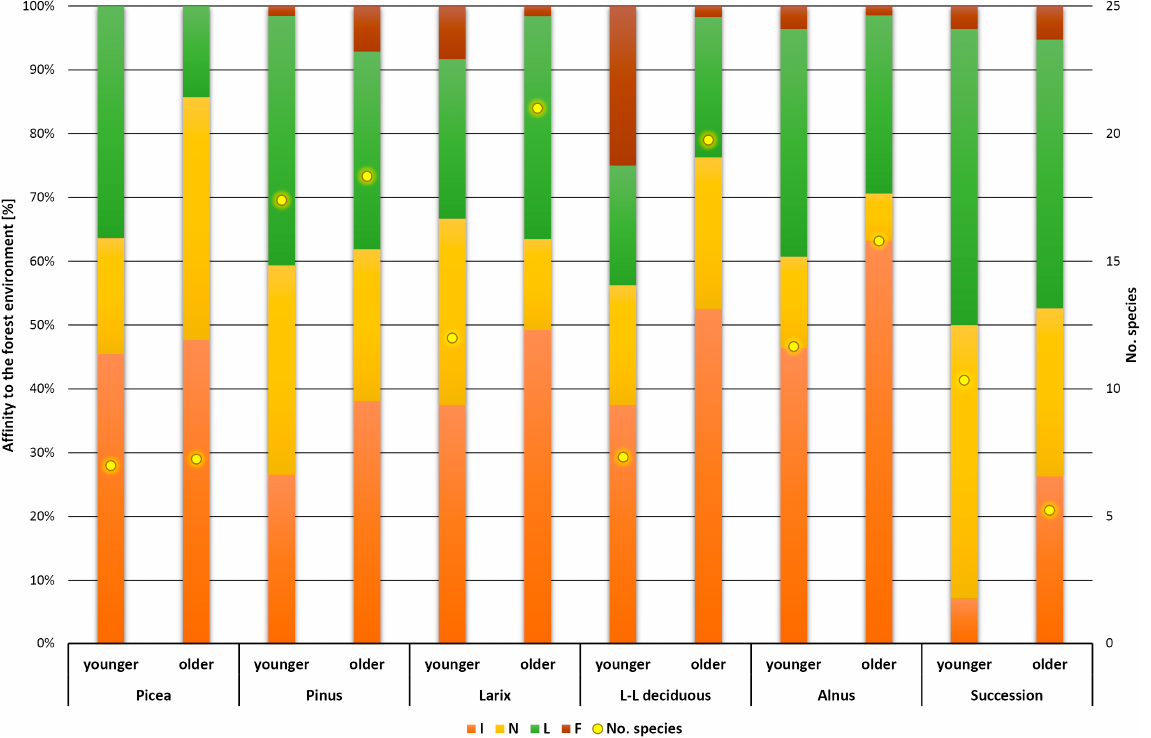
Figure 5. Affinity to the forest environment—distribution of functional groups in forest type and different ages. I—species occurring both in the forest and non-forest vegetation, N—species without spontaneously occurring in Czech forests, L—relatively a forest species, F—forest species.